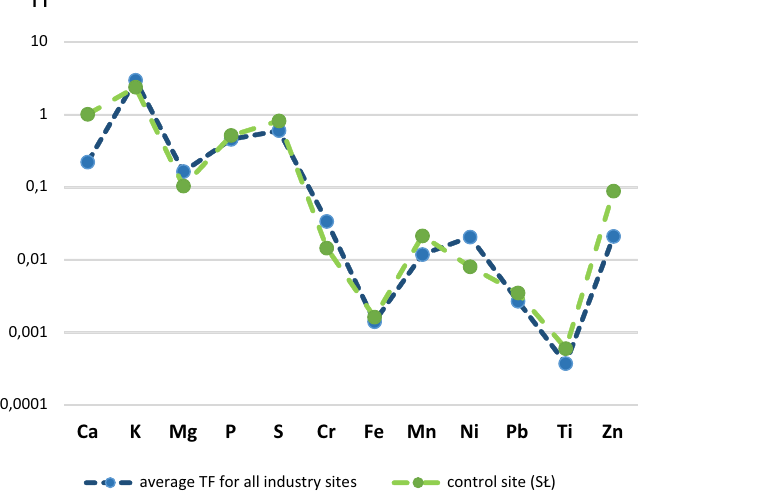
Figure 4. TF average values for industry areas and control